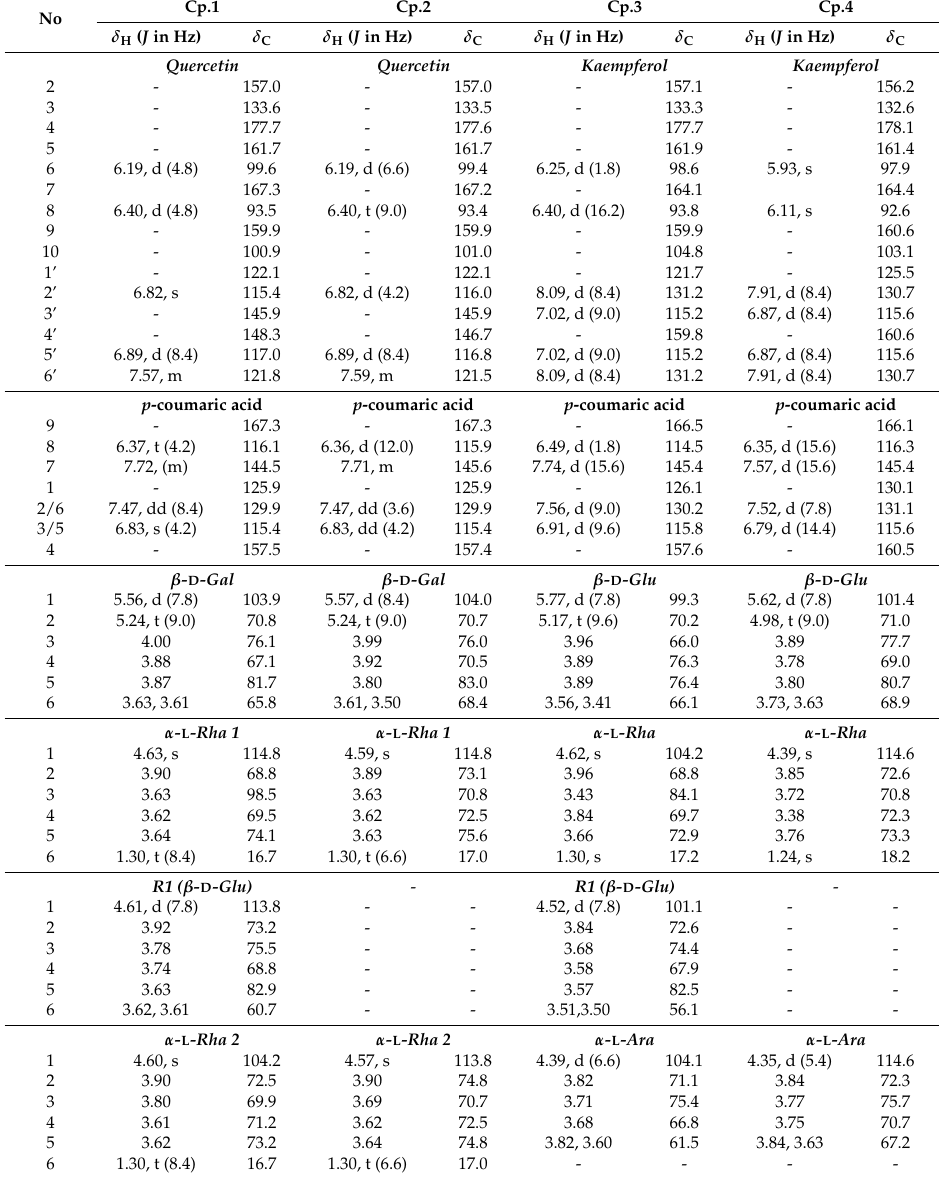
Table 1. 1 H and 13 C NMR spectroscopic data of four acylglycosides flavones (600 and 150 MHz, DMSO-d 6 ). No